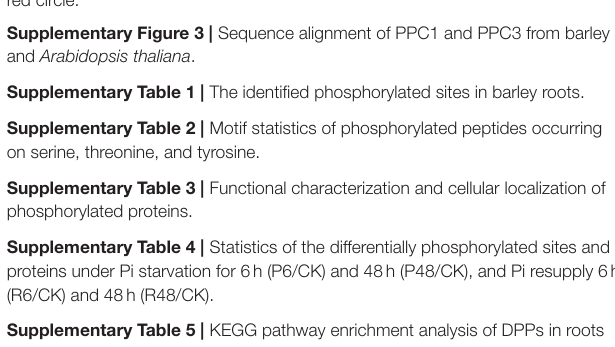
Supplementary Table 1 | The identified phosphorylated sites in barley roots. Supplementary Table 2 | Motif statistics of phosphorylated peptides occurring on serine, threonine, and tyrosine. Supplementary Table 3 | Functional characterization and cellular localization of phosphorylated proteins. Supplementary Table 4 | Statistics of the differentially phosphorylated sites and proteins under Pi starvation for 6h (P6/CK) and 48h (P48/CK), and Pi resupply 6h (R6/CK) and 48h (R48/CK).